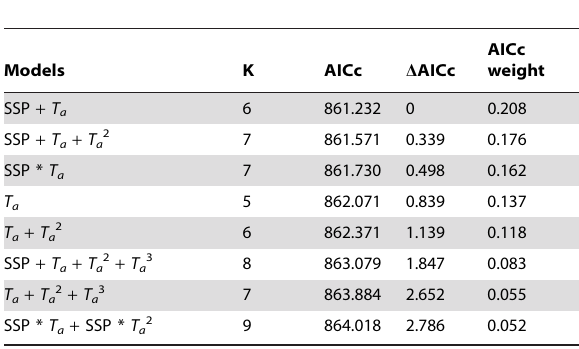
Table 2. Linear mixed models describing the surface temperature of the bill ( T bill ).